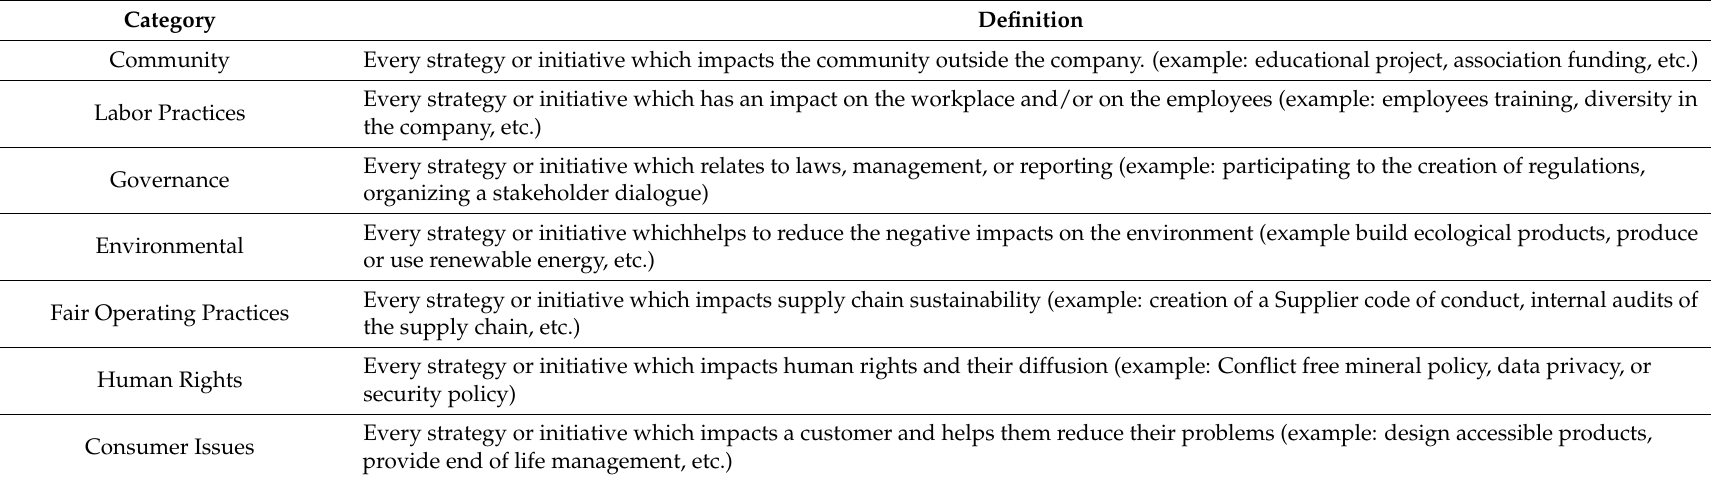
Table A2. Content classification